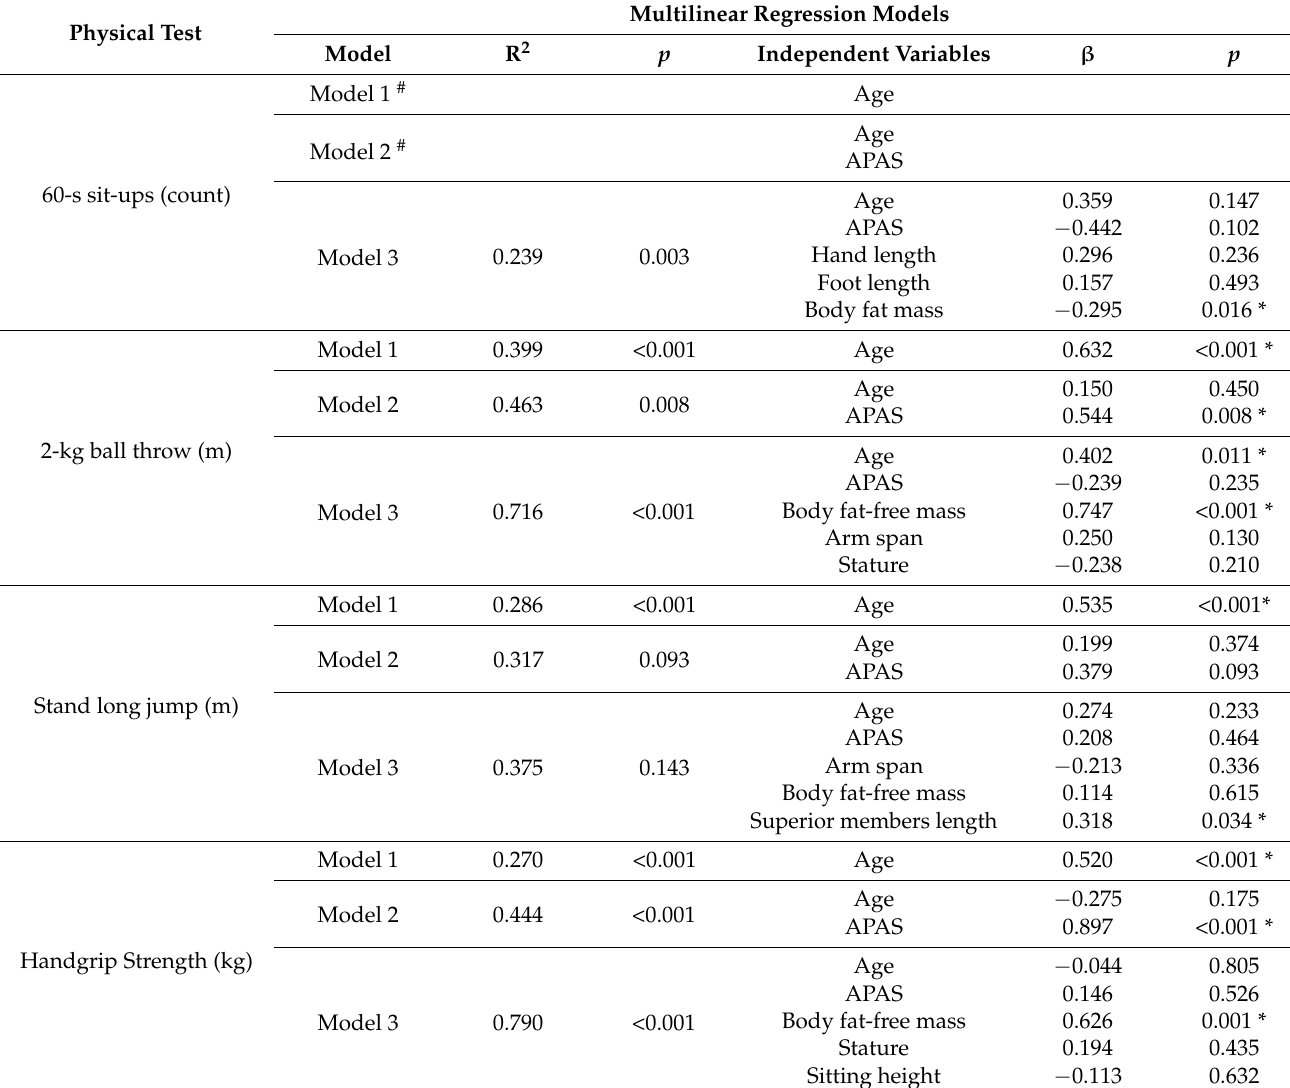
Table 4. Hierarchical multiple linear regression models for physical performance tests (neuromuscular strength) in youth male